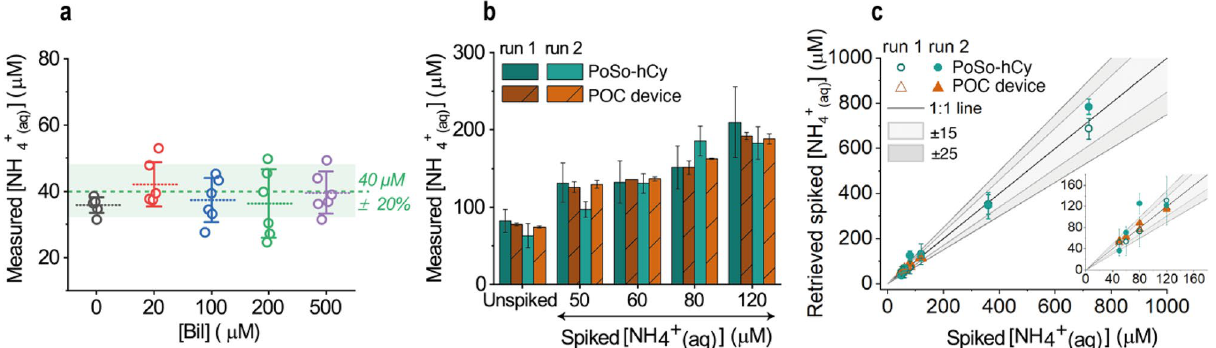
Figure 8. Alleviation of bilirubin interference and ammonia measurements in plasma with PoSo-hCy and a POC device. ( a ) [NH 4+ (aq) ] measured using PoSo-hCy in solutions containing 40 μM NH 4+ (aq) and various concentrations of Bil in PBS. Calibration curve from Supplementary Fig S11 was used. Results are shown as exact measured values and mean ± SD (n = 6) of independent replicate solutions. The nominal [NH 4+ (aq) ] with ± 20% RE is depicted as green dashed line and shaded area. Brown-Forsythe and Welch ANOVA (parametric; unmatched) statistical analysis was performed with Holm-Sidak’s multiple comparison tests, indicating non-significant differences compared to the control (p > 0.05) for all [Bil]. ( b ) [NH 4+ (aq) ] in unspiked and ammonia-spiked healthy human plasma samples as measured by the PoSo-hCy assay and the PocketChem device in two independent experiments (runs 1 and 2). For each run, data are presented as mean ± SD [n = 4 independent replicate solutions (PoSo-hCy); n = 2 independent replicate solutions (POC device)]. ( c ) Retrieved spiked [NH 4 + (aq) ] from ( b ) as a function of the nominal spiked [NH 4 + (aq) ]. The “1:1” black line corresponds to the ideal case where the retrieved spiked [NH 4 + (aq) ] equals the nominal one and grey areas indicate the corresponding ± 15% and ± 25% RE. Inset shows the same data but only up to 160 μM NH 4 + (aq) . Mean ± SD [n = 4 (PoSo-hCy); n = 2 (POC)]. Conditions: